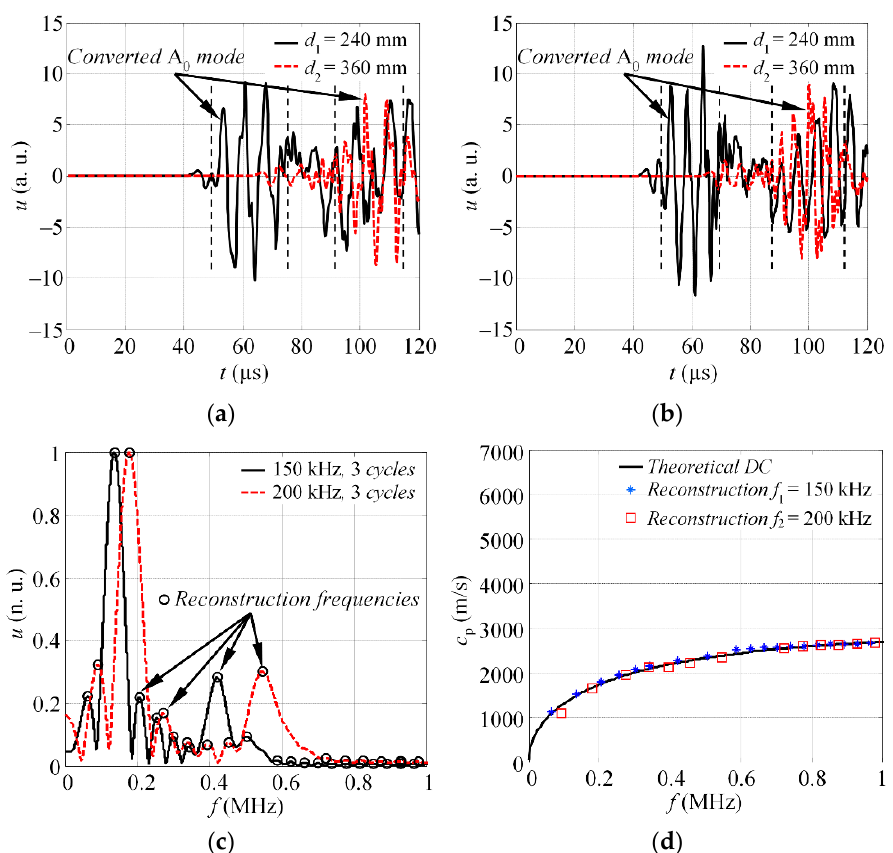
Figure 9. The simulated waveforms of the converted A 0 mode, at distances d 1 and d 2 , in case of ( a ) 150 and ( b ) 200 kHz excitation; ( c ) the magnitude spectra of windowed A 0 mode at different excitation frequencies; ( d ) the combined reconstruction of phase velocity dispersion curve along with the theoretical estimation.